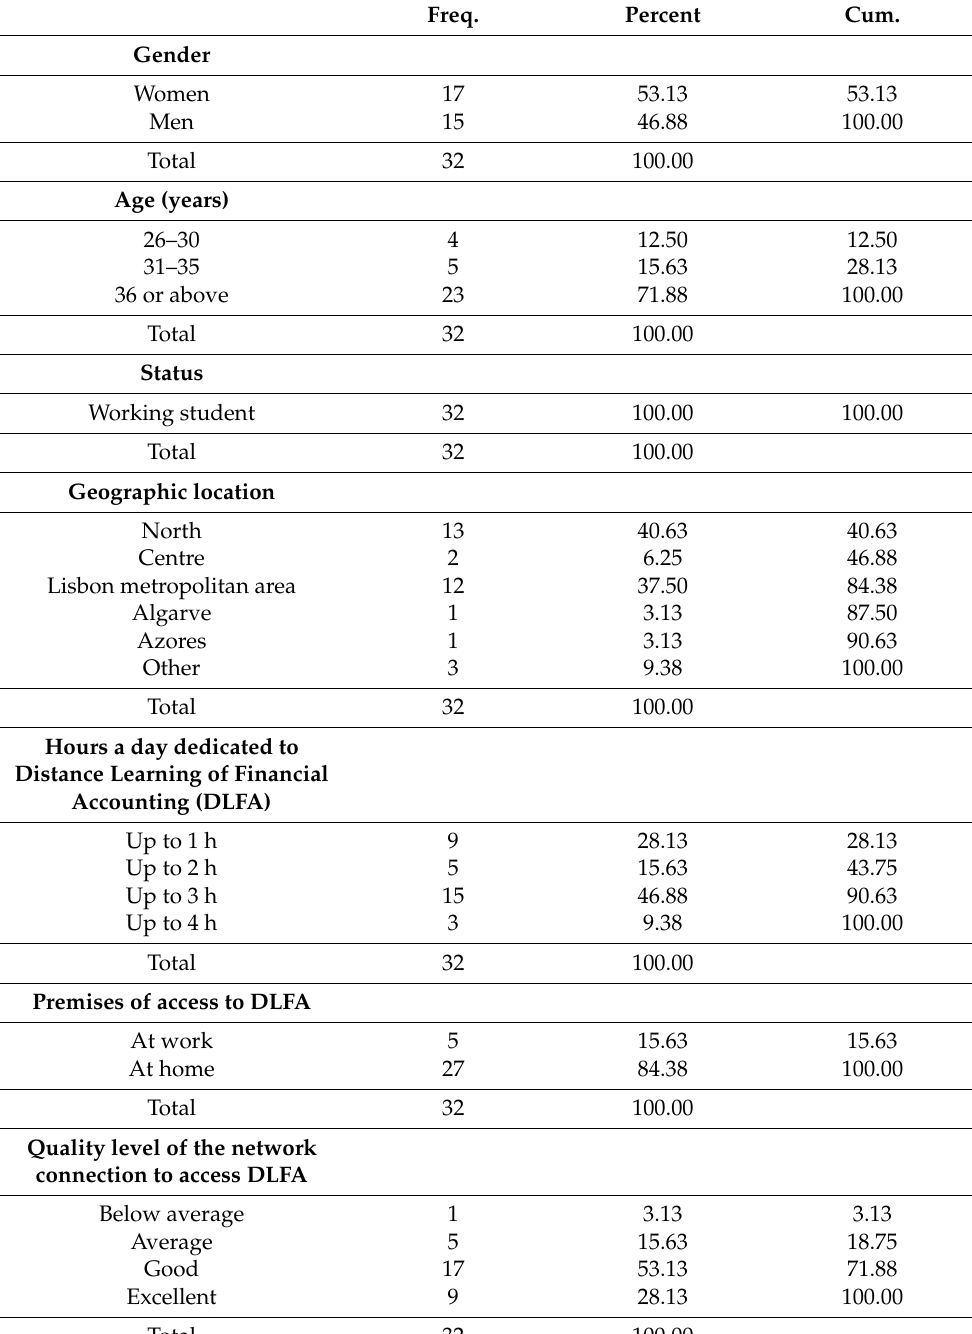
Table 2. Sociodemographic characteristics and descriptive